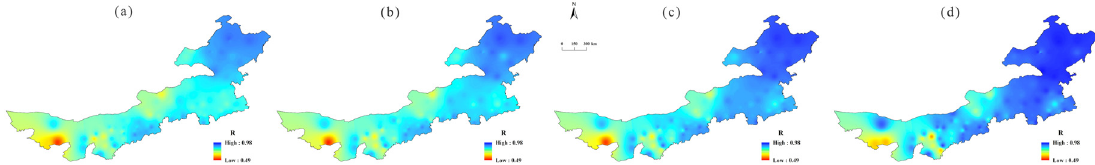
Figure 8. The spatial distribution of correlation between the SPI and SPEI in Inner Mongolia. ( a ) 1-month, ( b ) 3-month, ( c ) 6-month, and ( d ) 12-month timescales. All coefficients are significant with p < 0.05.